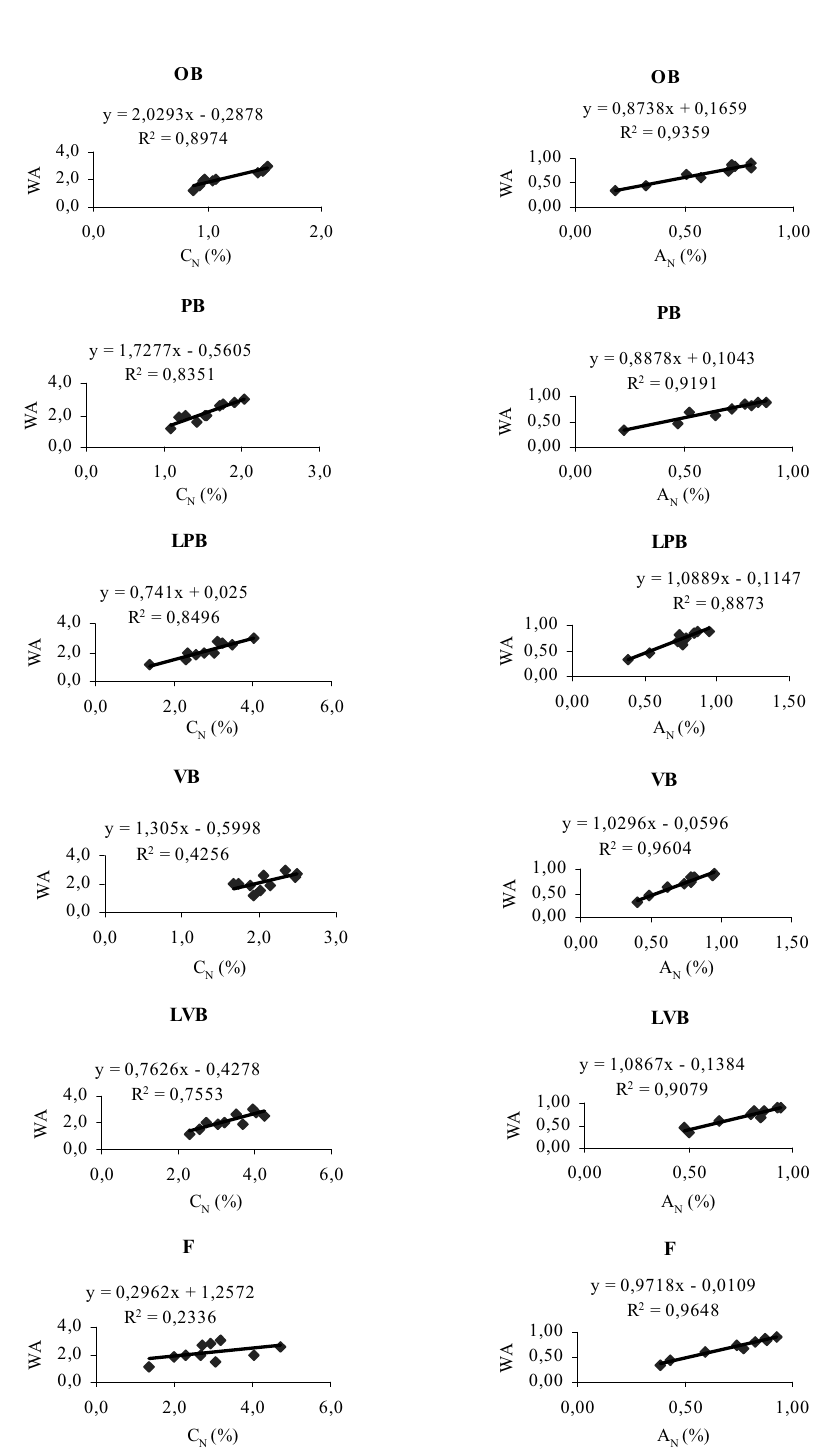
Fig. 1 – Linear regressions between weighted averages (WA of equation 4) and individual values of C N and A N for the different compartments, measured at nine sampling times over a two year period (OB = orthotropic branch, PB = plagiotropic branch, LPB = leaf of plagiotropic branch, VB = vegetative branch, LVB = leaf of vegetative branch, and F = fruit).